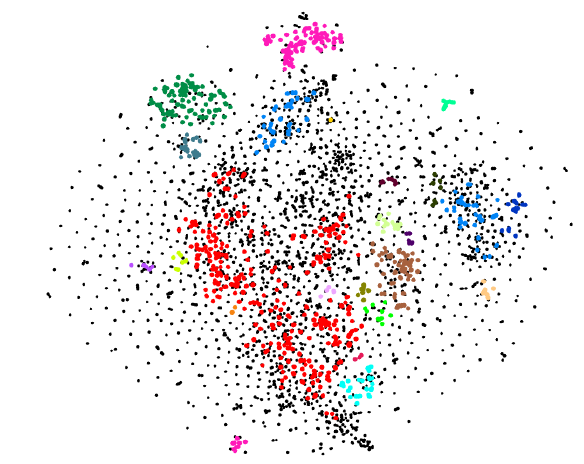
Figure 6. t-SNE embedding of the deformation space with clusters. The colors correspond to the ALS point cloud (Fig. 5) and the time series in Figure